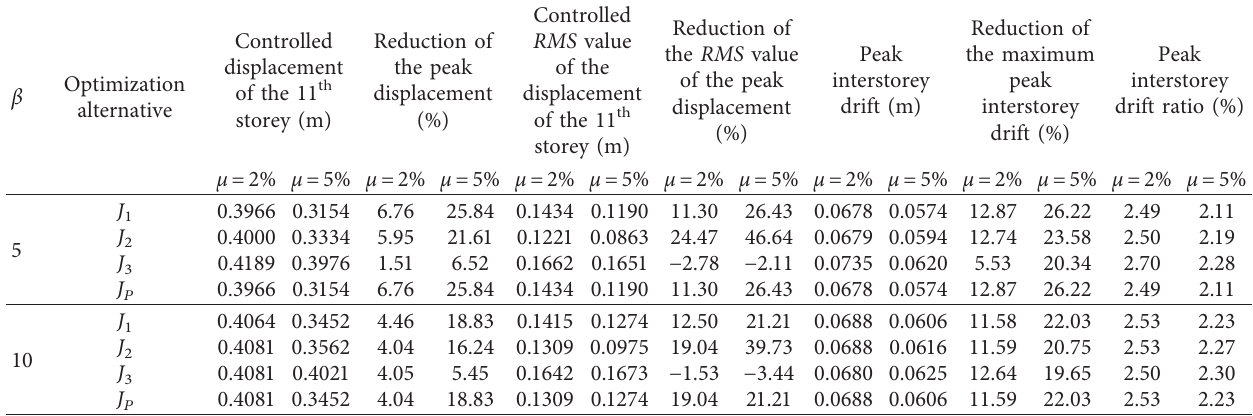
Table 11: Controlled response of the structure subjected to “ El Centro ”